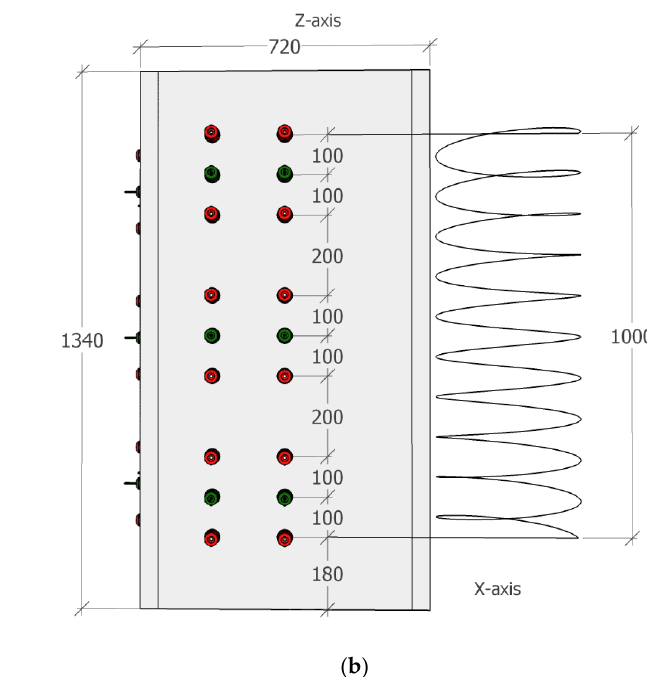
Figure 6. ( a ) physical model and ( b ) 2D dimensions of the container and sensor positions side view (dimensions in mm).